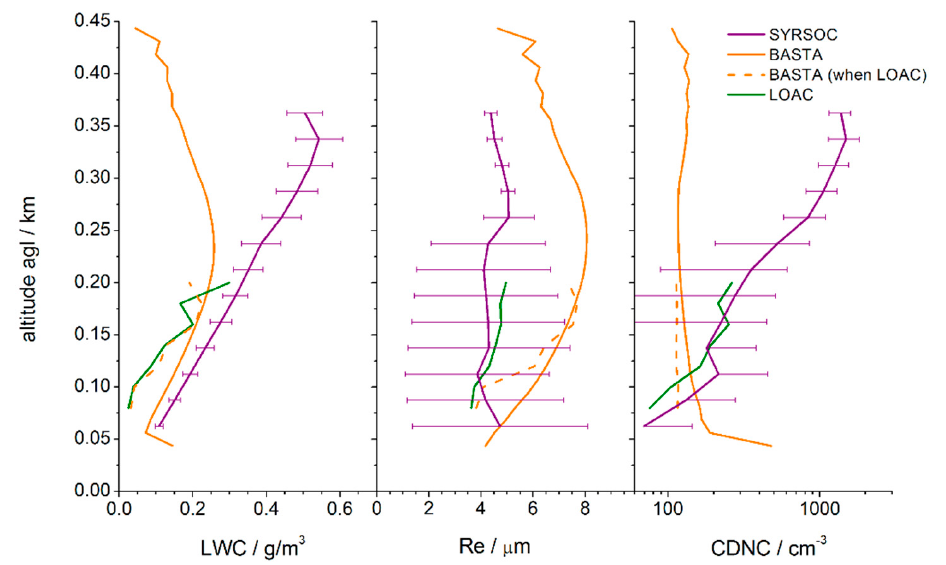
Figure 13. Vertical profile of LWC ( left ), Re ( middle ), CDNC ( right ) derived from LOAC, BASTA, and SYRSOC algorithm between 14:00 and 16:00 on 6 January 2015. Error bars on SYRSOC profiles indicate standard deviation of the mean over the 2-h period.